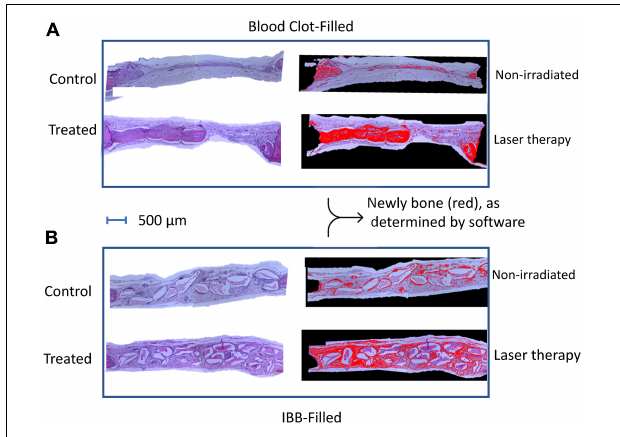
FIGURE 4 | Photomicrographs of representative images of hematoxylin-eosin (HE) sections of both subgroups, the blood clot (A) , and the IBB filled cavities (B) . Images were delimited with the aid of imaging software to compare the areas of newly formed bone (in red